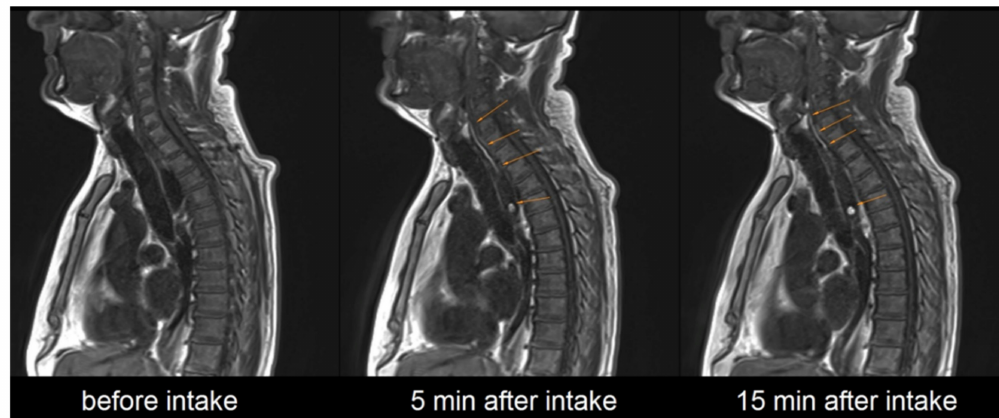
Figure 4. Exemplary representation of sagittal image acquisition before, 5 min after and 15 min after intake of the EsoCap system.